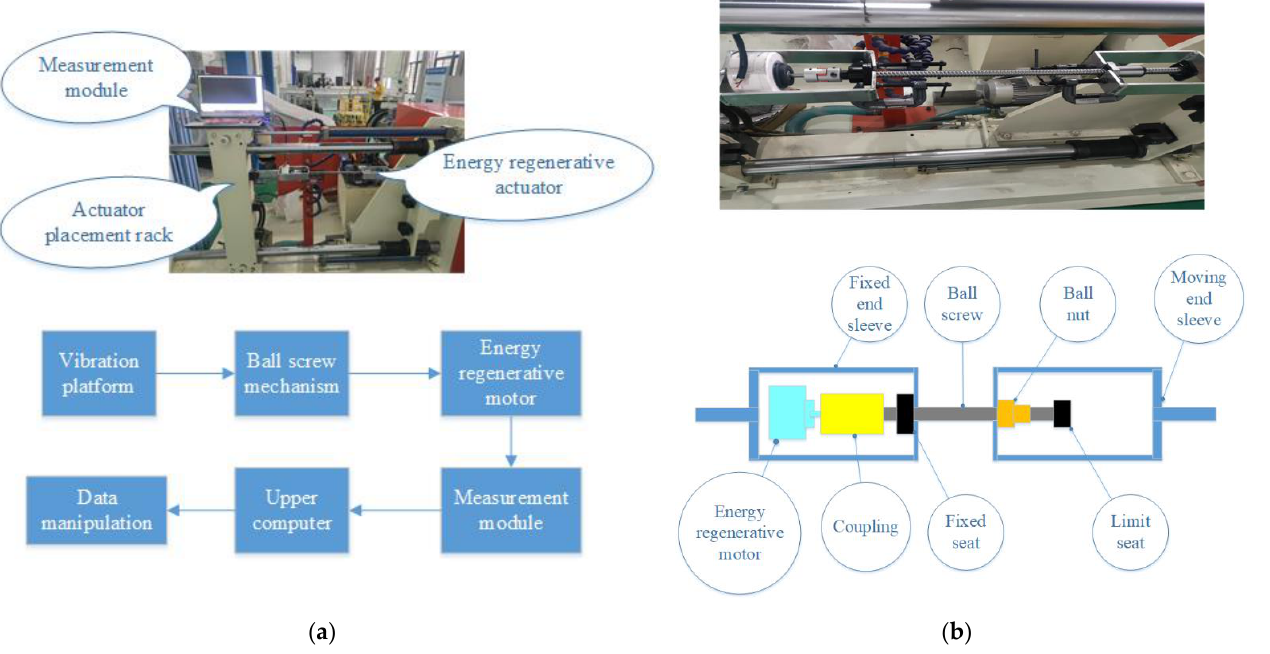
Figure 8. Equipment for energy recovery tests. ( a ) General assembly drawing of the test stand and workflow; ( b ) Diagram of the energy recovery actuator.